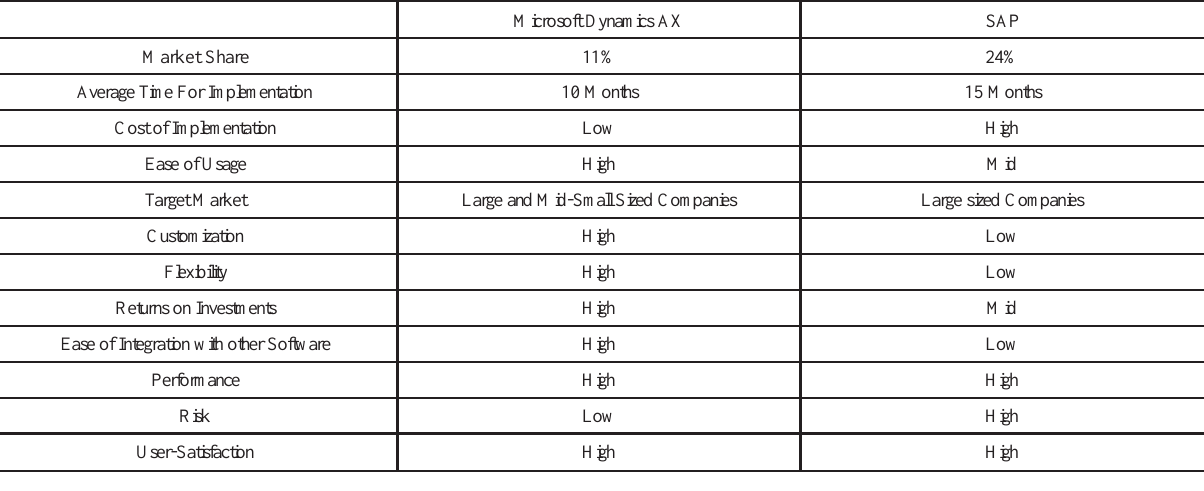
TABLE 1. COMPARISON CHART BETWEEN MICROSOFT DYNAMICS AX AND SAP